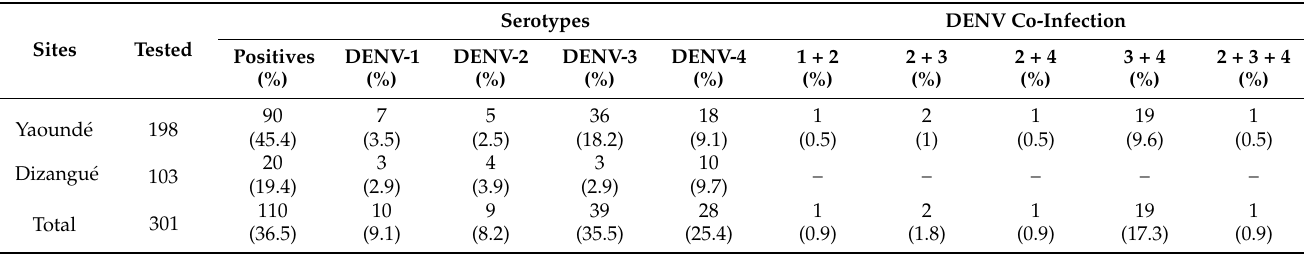
Table 4. Dengue serotypes and co-infections by different serotypes, according to study site.